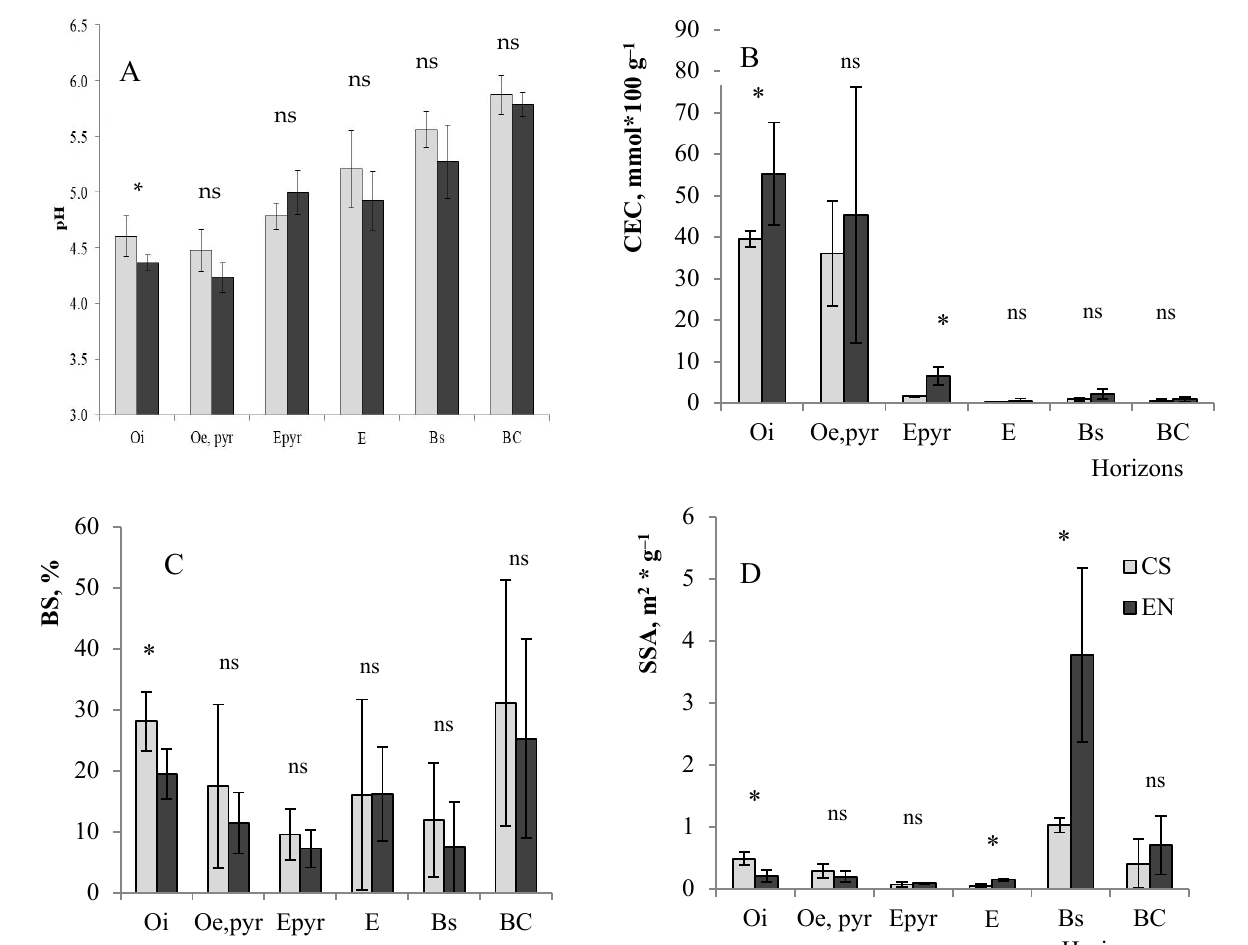
Figure 3. pH (water) values ( A ), cation exchange capacity ( B ), and base saturation ( C ) and specific surface area (SSA) values for albic podzols ( D ) ( n = 3, the error bars are the standard errors). Abbrevi- ation: CS—Central Siberia, EN—European North. *—indicate significant differences between EN and CS, ns—differences between EN and CS are not significant at p < 0.05.